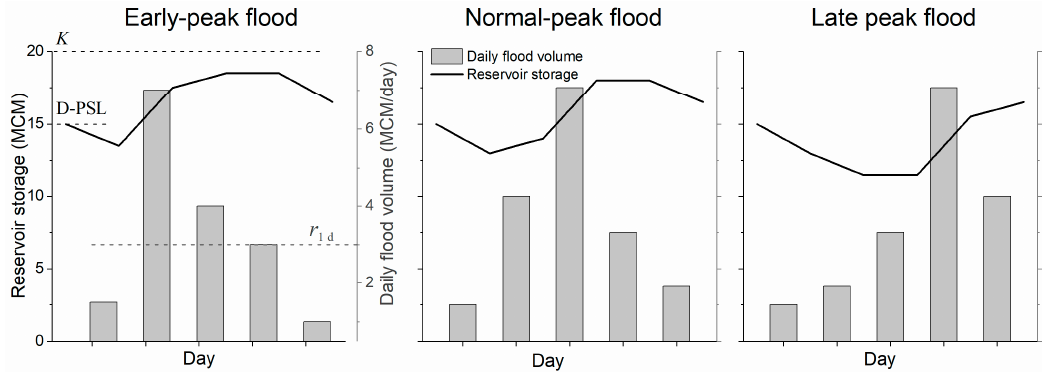
Figure 3. The flood regulation process under three different types of flood shapes.